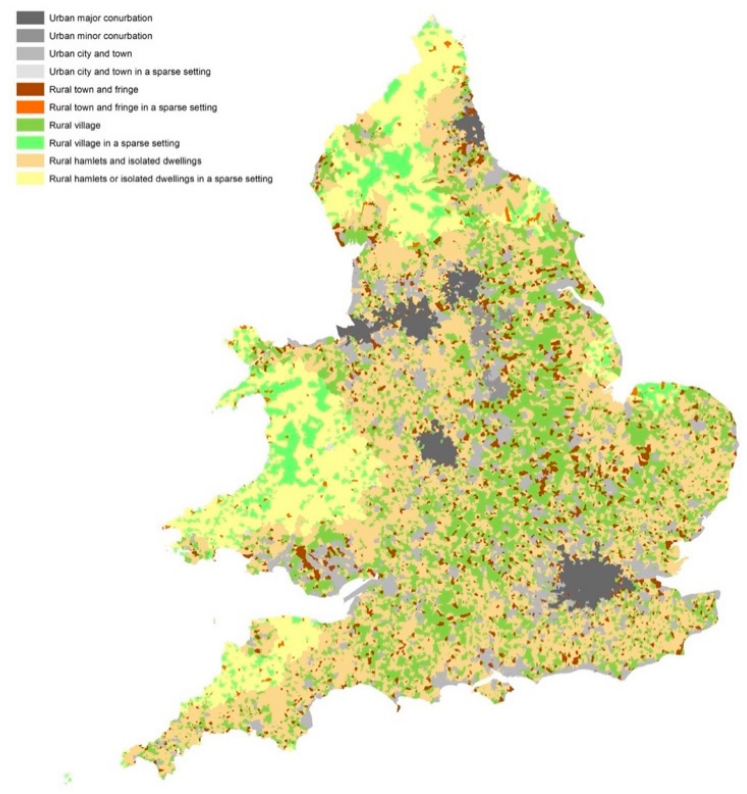
Figure 3. English and Welsh 2011 census output areas: rural-urban typology (RUC2011) [25]. In this project, rural areas consist of three types: ‘largely rural’, ‘mainly rural’, and ‘urban with significant rural’. After selecting the corresponding codes, according to Table 1, in Table 2, we collected licensed EVs numbers of 138 rural areas. The 138 groups of data are the basis for the cost-effectiveness analysis. After distinguishing where the rural areas are, this paper seeks business strategies for PCS. As presented in Table 2, the lines in Bold are rural area data. In the U.K., London is the municipality with the highest number of battery-electric and plug-in hybrid cars [16]. Table 1. Local authority districts ranked by rural and hub-town (rural-related) populations from the 2011 rural-urban classification [30].